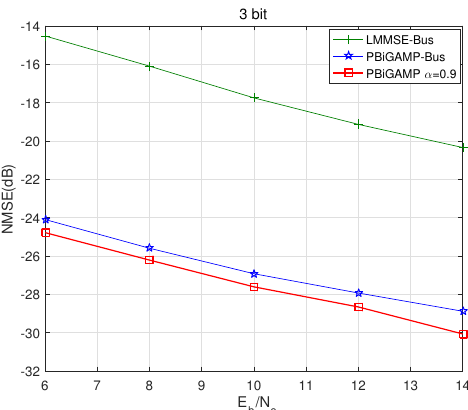
Figure 7. Channel estimation NMSE versus E b / N o at 10-th Turbo iteration for investigated algorithms.